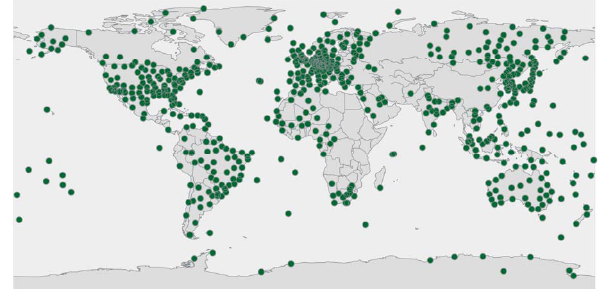
Fig. 1. Locations of the radiosonde stations used in both the Figure 1. Location of the radiosonde stations used in both the SCIAMACHY-ESA and SCIAMACHY-ESA and SCIAMACHY-IMLM water vapour col- SCIAMACHY-IMLM water vapour column inter-comparisons with radiosonde WVC data. umn intercomparisons with radiosonde WVC